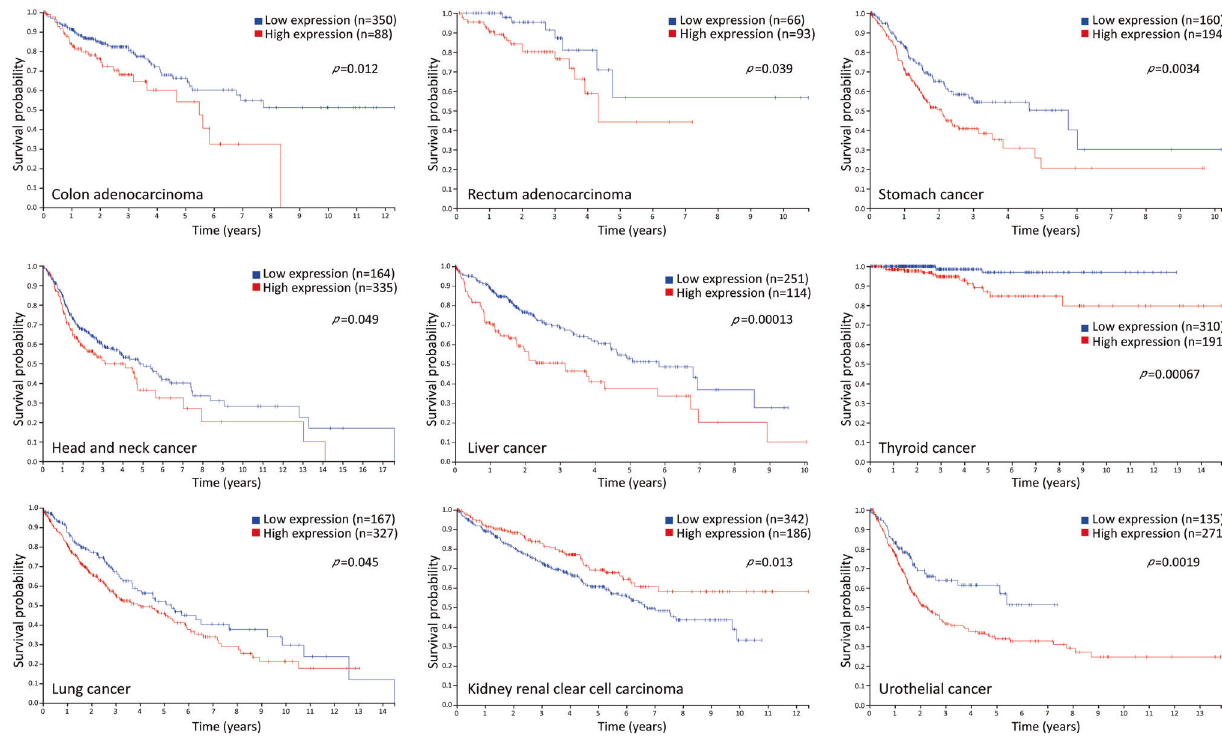
Fig. 4 High FBXL7 expression predicts a poor patient survival in a variety of human cancers. FBXL7 expression is markedly associated with patient survival in various cancers according to the Human Protein Atlas database. Blue line: low FBXL7 expression; red line: high FBXL7 expression. The p -value for the log-rank test is